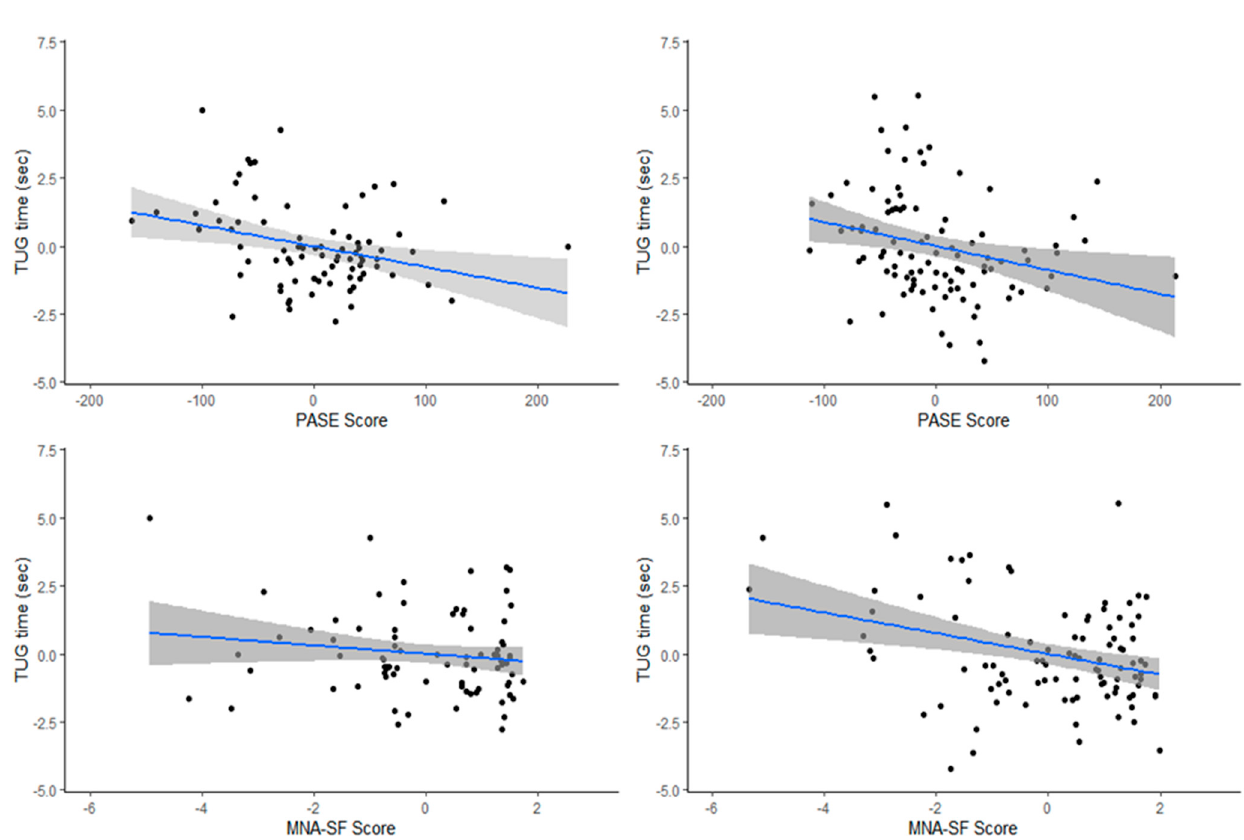
Figure 1. Partial correlation plots (adjusted for age, area of residence and body mass index) with standard error for PASE score and MNA-SF score with TUG time (s) in ( a ) males and ( b ) females.